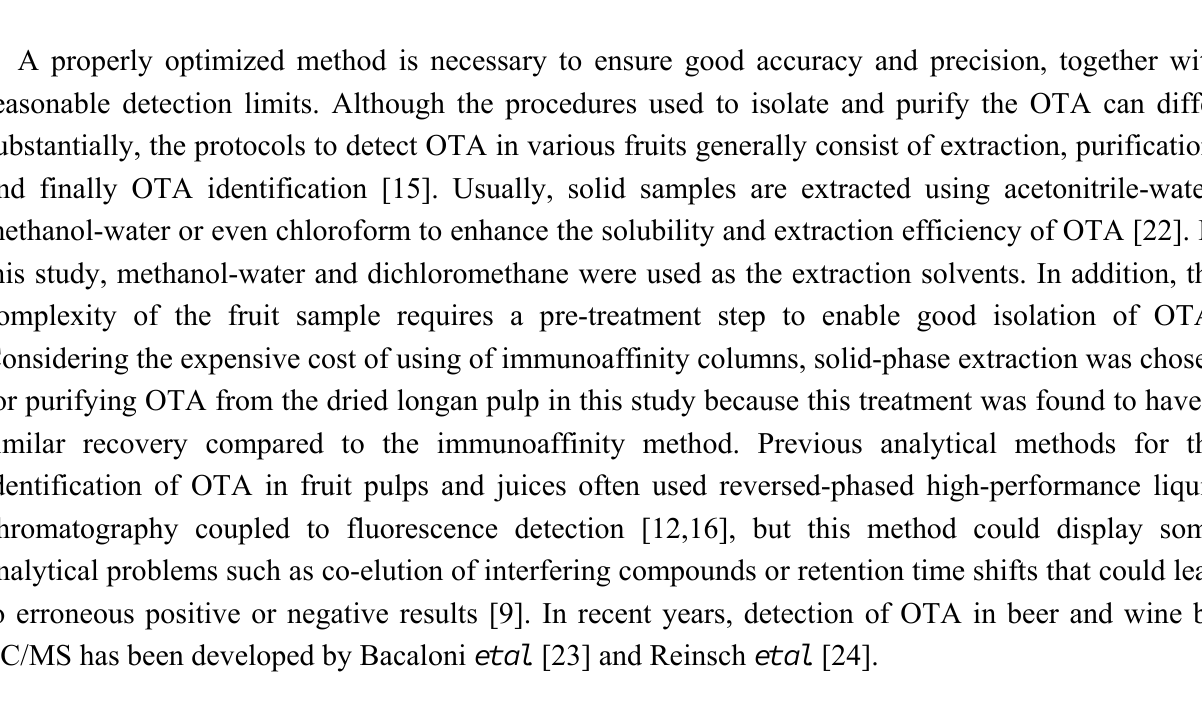
Figure 1. HPLC-FD ( λ ex = 333 nm and λ em = 460 nm) of ochratoxin A standard (a) and the pulp extracts from good (b) and diseased (c) longan